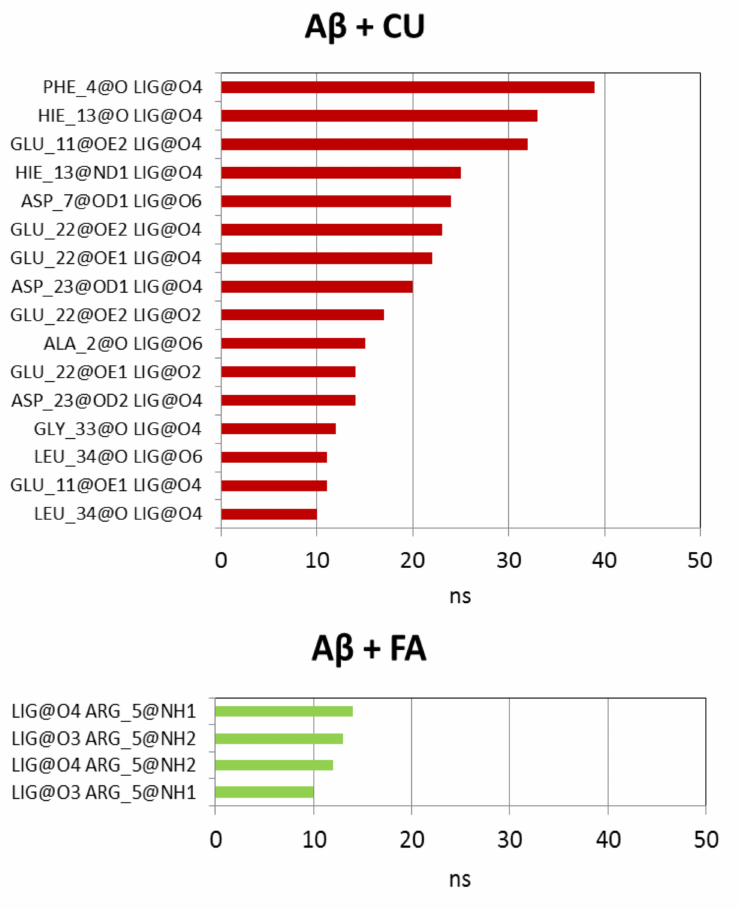
Figure 8. Intermolecular hydrogen bonds between A β peptide and ligands CU and FA with lifetime ≥ 10